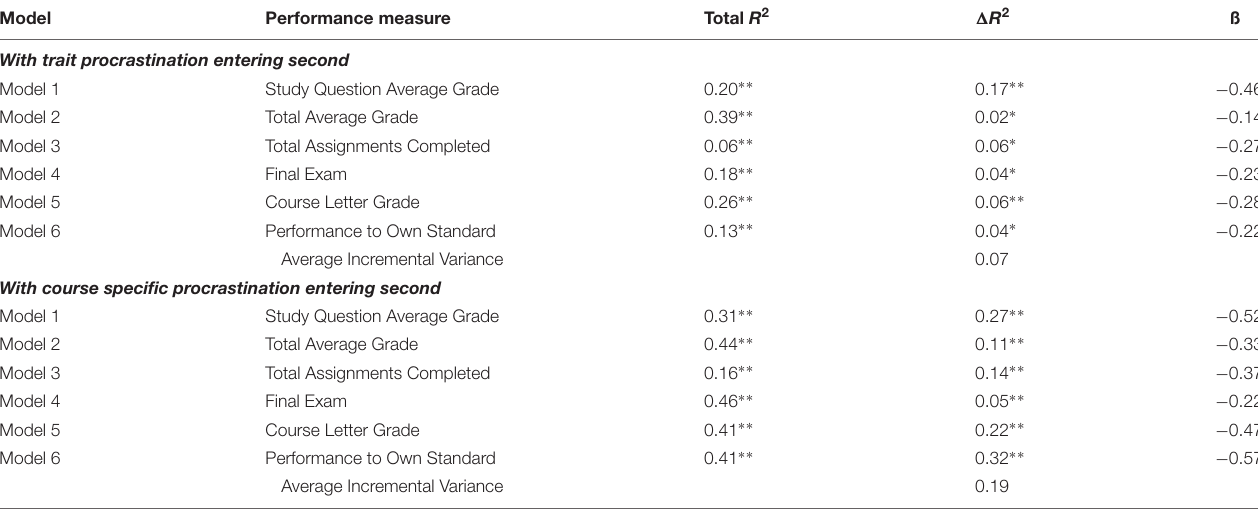
TABLE 2 | Hierarchical regression analyses for determining the incremental predictiveness of trait and course specific procrastination above GMA and conscientiousness for performance.